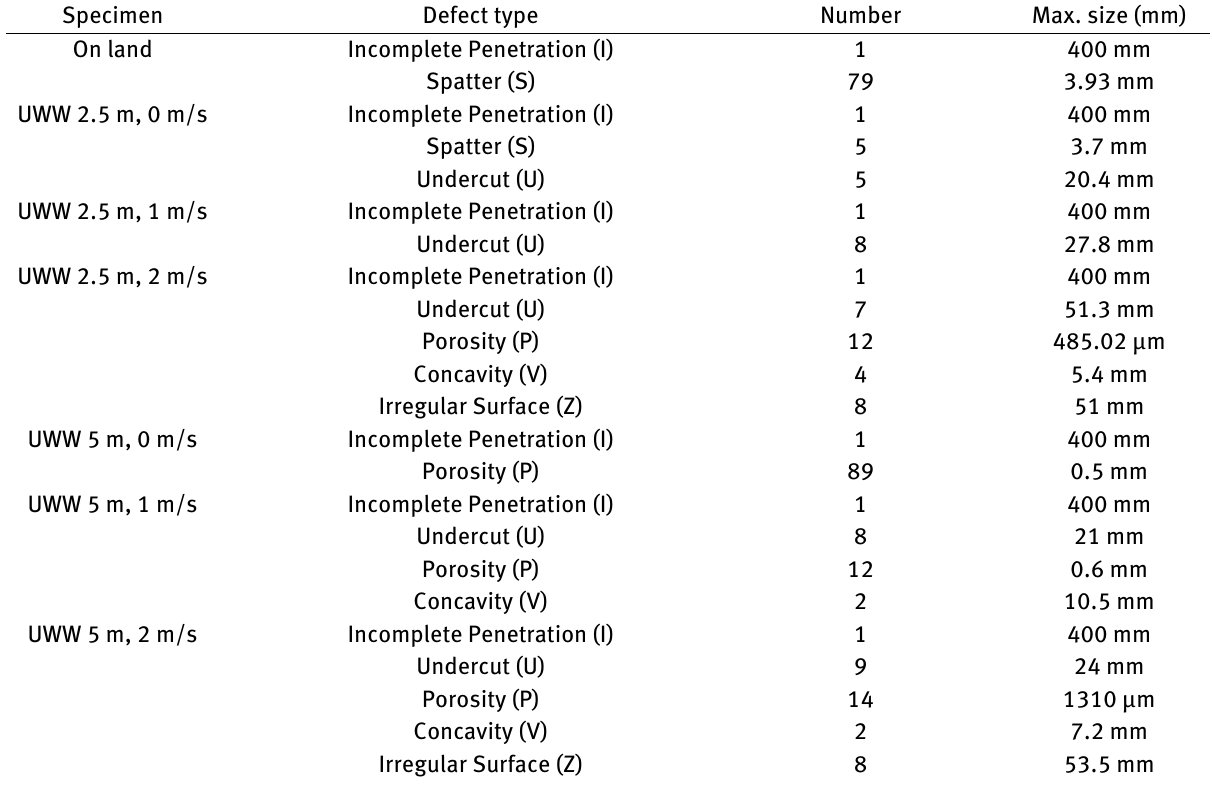
Table 2: List of welding defects based on the radiographic test.